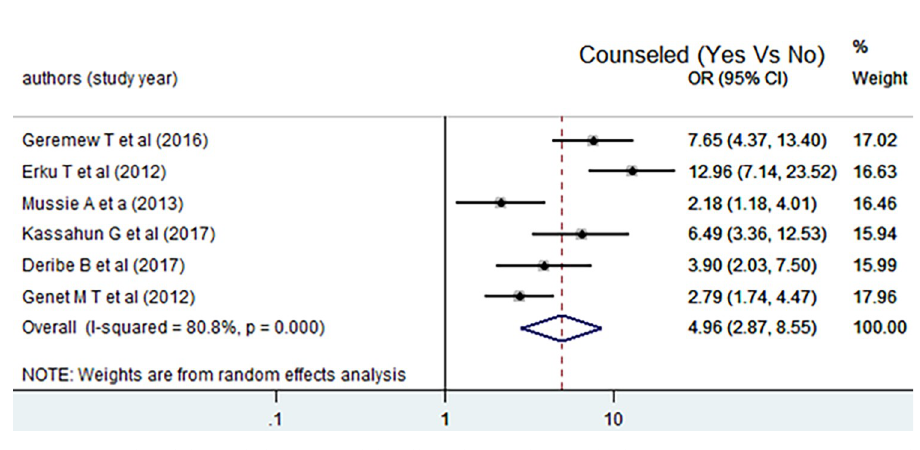
Fig 4. Forest plot of subgroup analysis by region among adult HIV infected peoples using the random effect model, a systematic review and meta-analysis, Ethiopia, 2020.